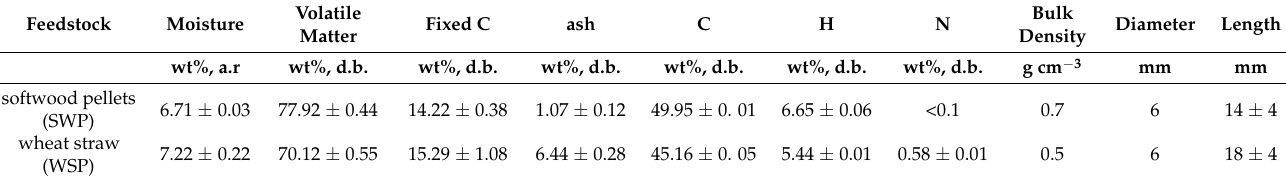
Table 1. Biomass feedstock composition. Mean values and standard deviations for five replicates are provided.